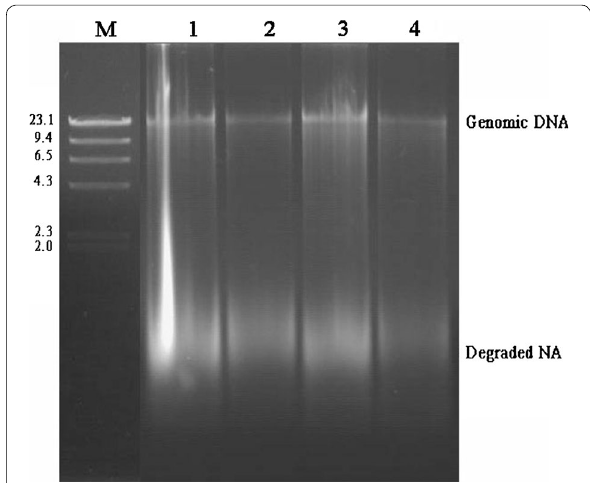
Fig. 1 Agarose gel electrophoresis of the genomic DNA extracted from the intestinal microflora of Cyprinus carpio var. Koi using the CLU method. Lanes: M , molecular marker. 1, incubation temperatures of 37 °C for lysozyme and 37 °C for RNase were used; 2, incubation temperatures of 37 °C for lysozyme and 30 °C for RNase were used; 3, incubation temperatures of 60 °C for lysozyme and 37 °C for RNase were used; and 4, incubation temperatures of 60 °C for lysozyme and 30 °C for RNase were